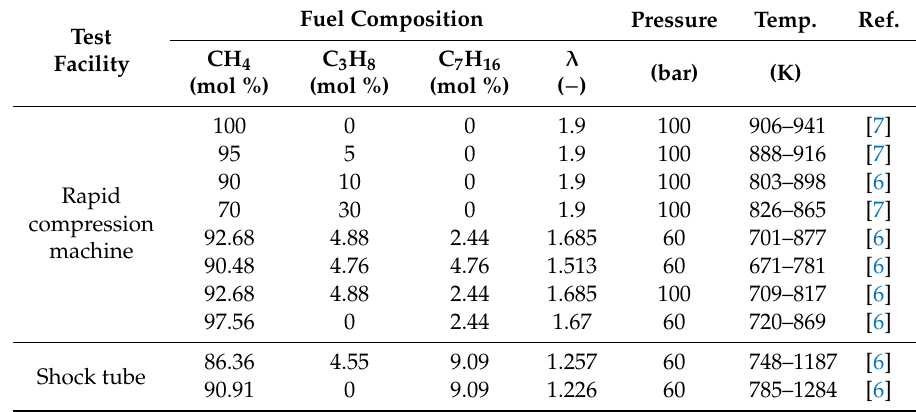
Table 1. Overview of the considered homogeneous mixtures for the evaluation of the investigated n -heptane mechanisms.